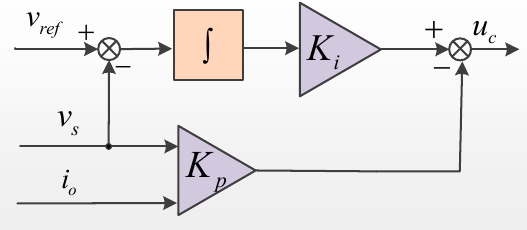
Figure 2. Output feedback controller.